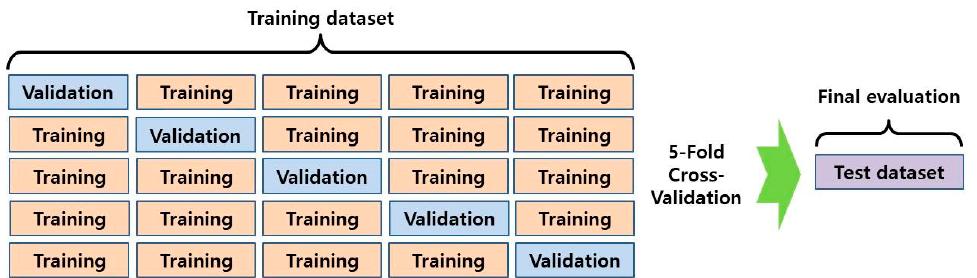
Figure 1. The overview of the 5-fold cross-validation used in this study. The landmarks of the patients’ cephalometric radiographs were automatically detected with a software program using a gradient boosting algorithm (WebCeph, AssembleCircle, Seoul, Korea). WebCeph has been used for landmark detection in several studies